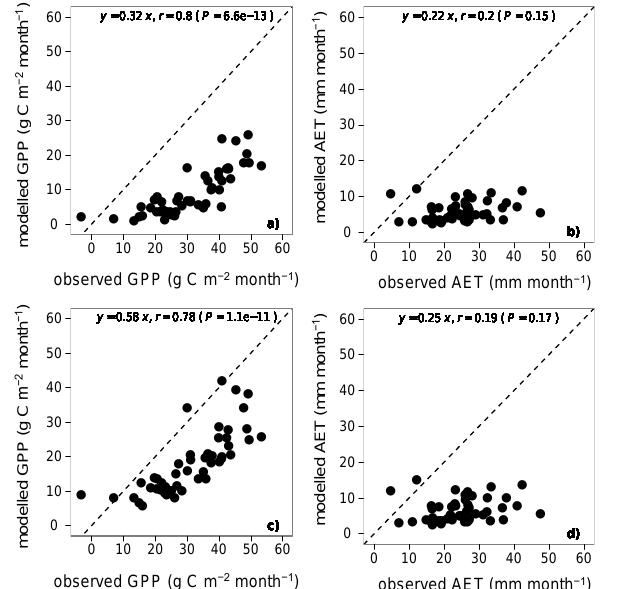
Figure 6. Variability during winter on monthly timescale for (a, b) GPP (gCm − 2 month − 1 ) and (c, d) AET (mmmonth − 1 ), between default settings (S1, a and c ) and changed t scalar (pstemp, b and d ) during winter. All days in December, January, and February are included (i.e. no selection for radiation). All slopes significantly dif- fered from 1.0 ( P< 0 . 05). RMSE values: (a) 22.7, (b) 20.4, (c) 14.7, and (d)